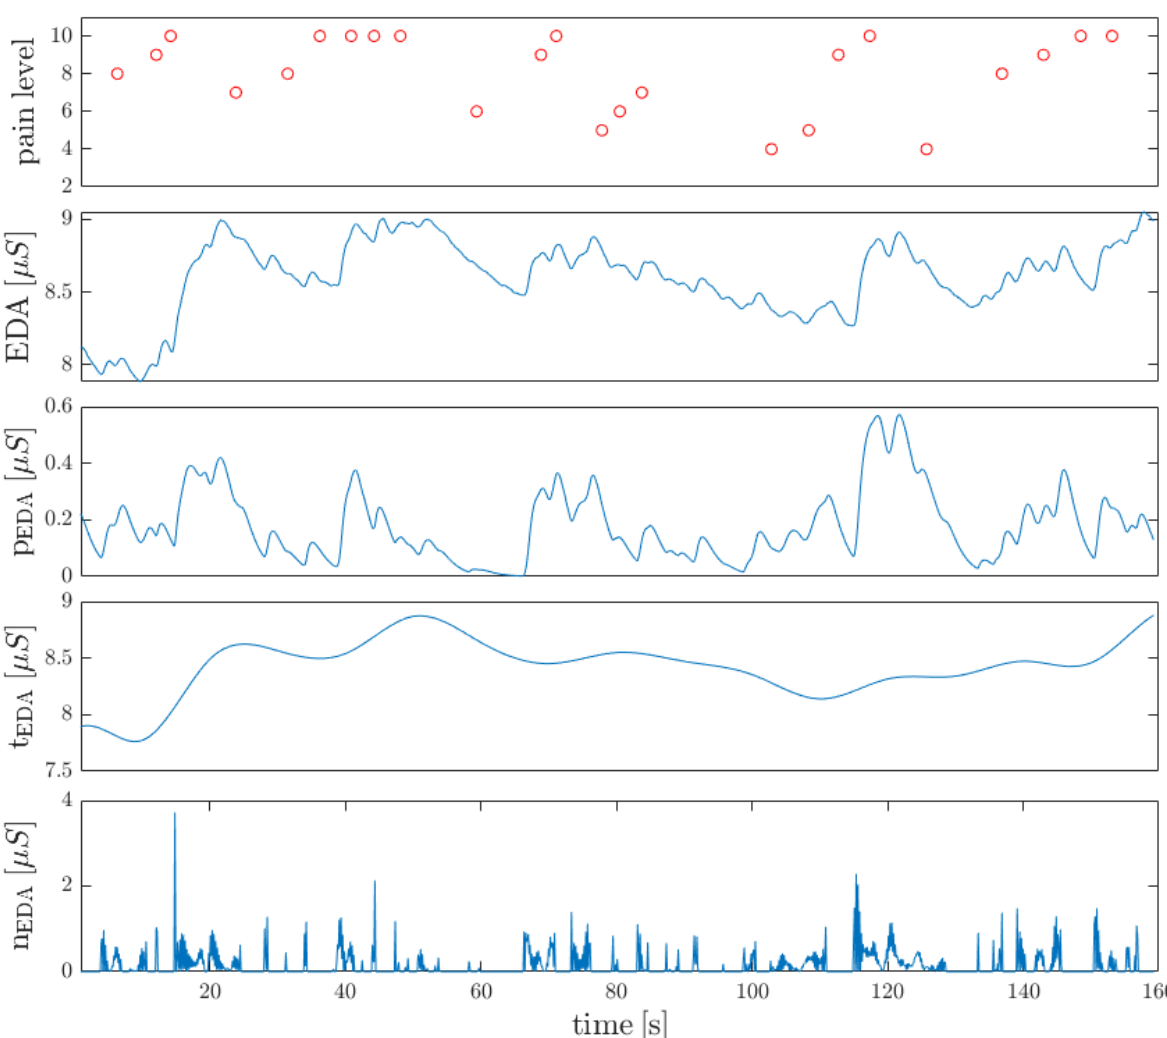
Figure 7. The results of convex optimization algorithm applied to resampled EDA signal: phasic ( p EDA ), tonic ( t EDA ), and noise ( n EDA ) components. Significant increase in p EDA amplitude can be noticed especially for pain labels greater than 8 (top chart). The data come from the therapy